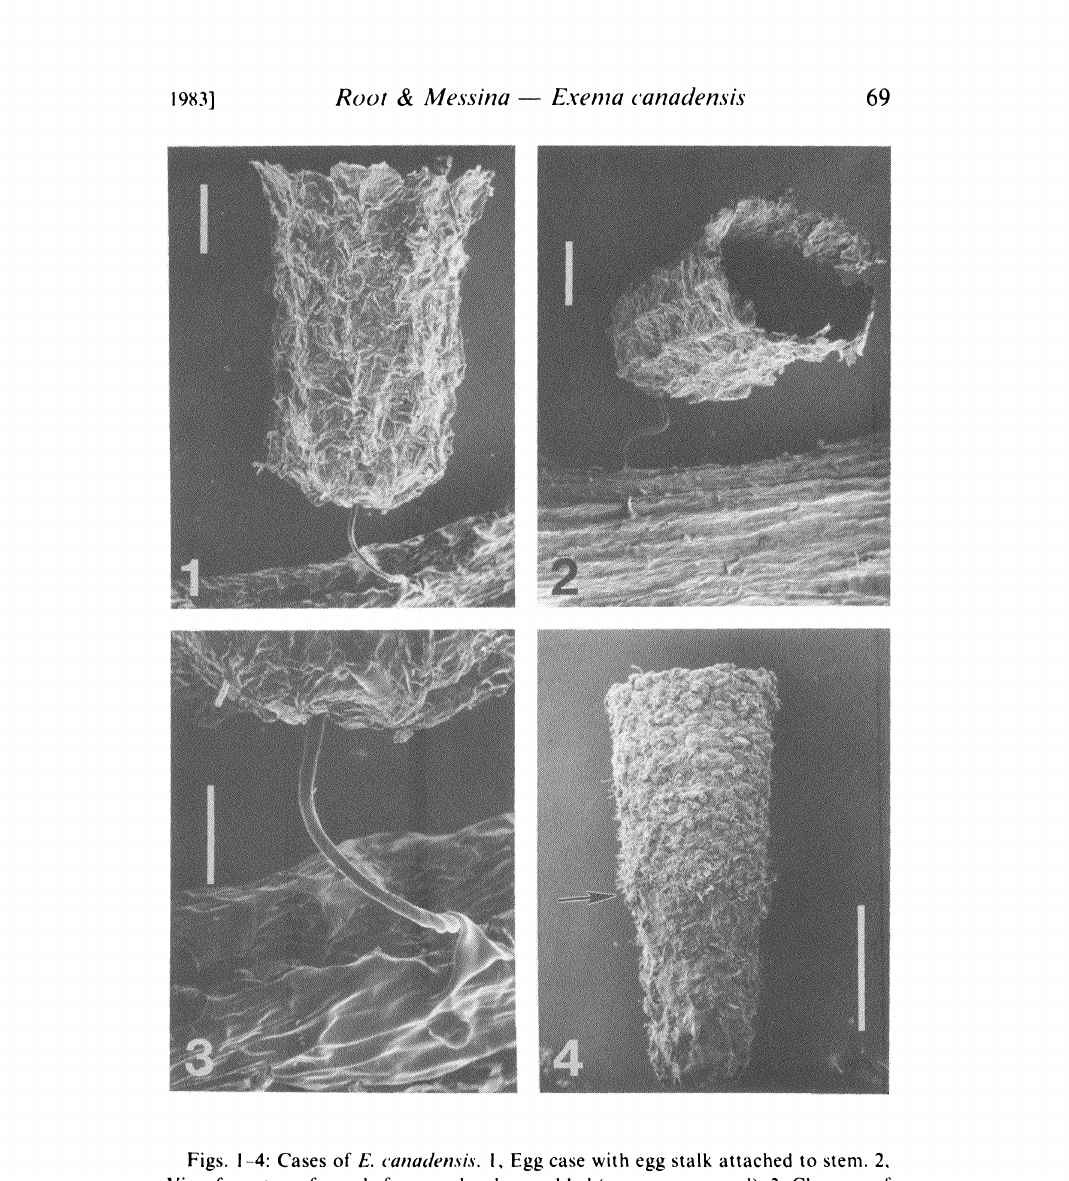
Figs. !-4: Cases of E. canadensis. I, Egg case with egg stalk attached to stem. 2, View from top of case beforecap has been added (egg was removed). 3, Close-up of egg stalk and base. 4, Case of st instar larva. Arrow indicates juncture between original egg case and larval additions. Scale bars 500 (Fig. 4), 200 (Figs. I-2), or I00 (Fig. 3)